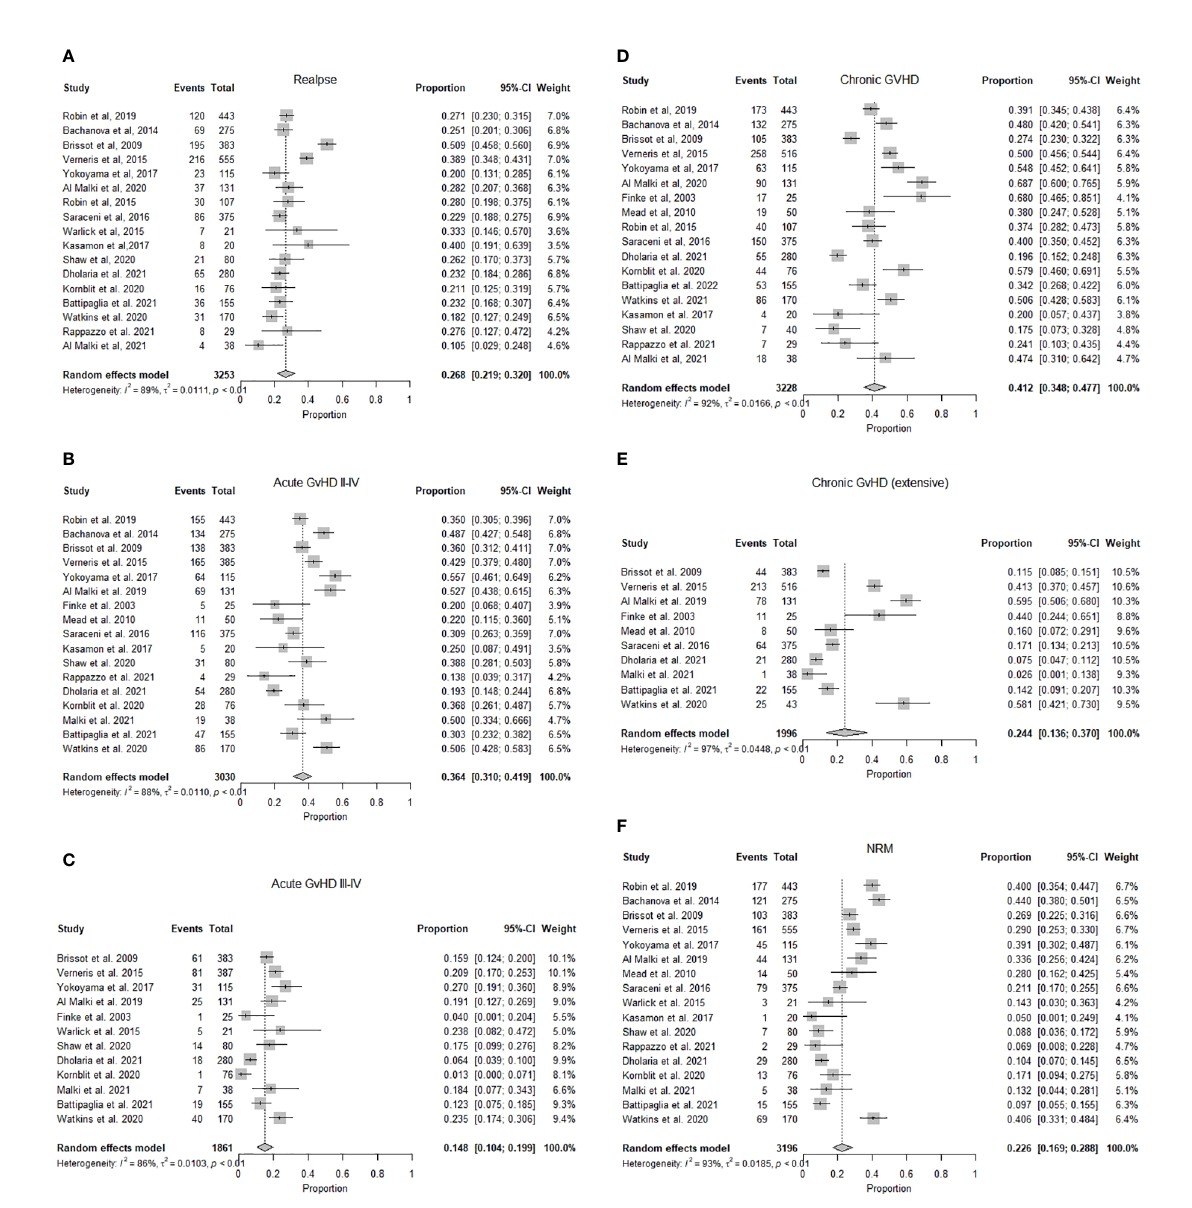
FIGURE 3 (A) Forest plot of pooled incidence of relapse after mismatched unrelated donor allogeneic stem cell transplant (n=3253). (B) Forest plot of pooled incidence of acute graft versus host disease grade (II-IV) after mismatched unrelated donor allogeneic stem cell transplant (n=3030). (C) Forest plot of pooled incidence of acute graft versus host disease grade (III-IV) after mismatched unrelated donor allogeneic stem cell transplant (n=1861). (D) Forest plot of pooled incidence of chronic graft versus host disease after mismatched unrelated donor allogeneic stem cell transplant (n=3228). (E) Forest plot of pooled incidence of chronic graft versus host disease (extensive) after mismatched unrelated donor allogeneic stem cell transplant (n =1996). (F) Forest plot of pooled incidence of non-relapse mortality after mismatched unrelated donor allogeneic stem cell transplant